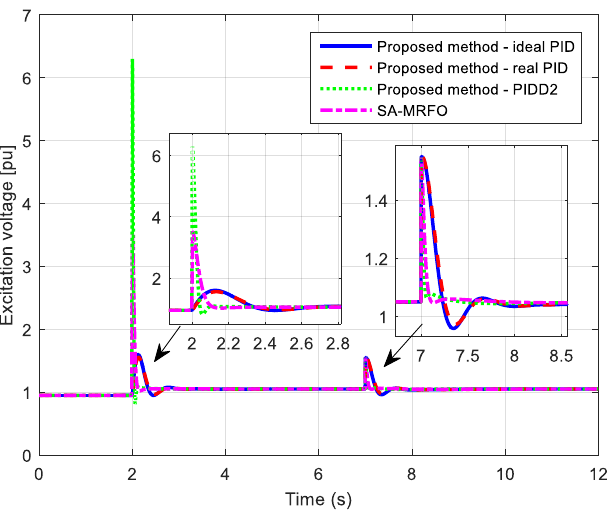
Table 7. The optimal values of PIDD2 controller parameters obtained using the proposed method (SA – GTO).